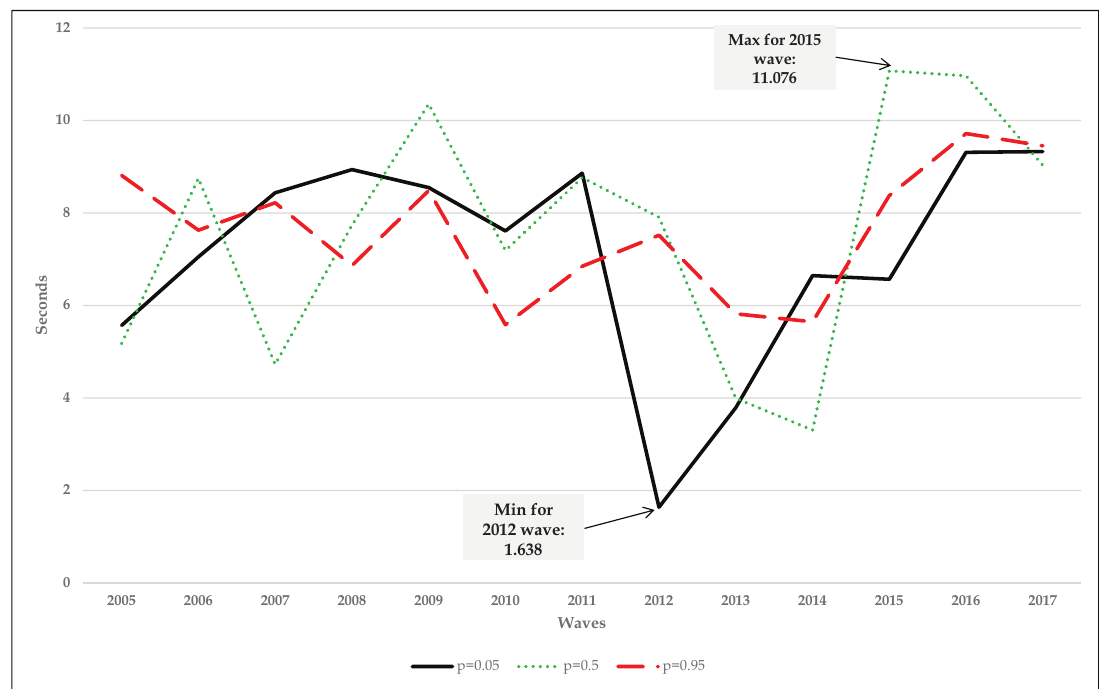
Figure 3. Time needed to obtain the subsamples for several p